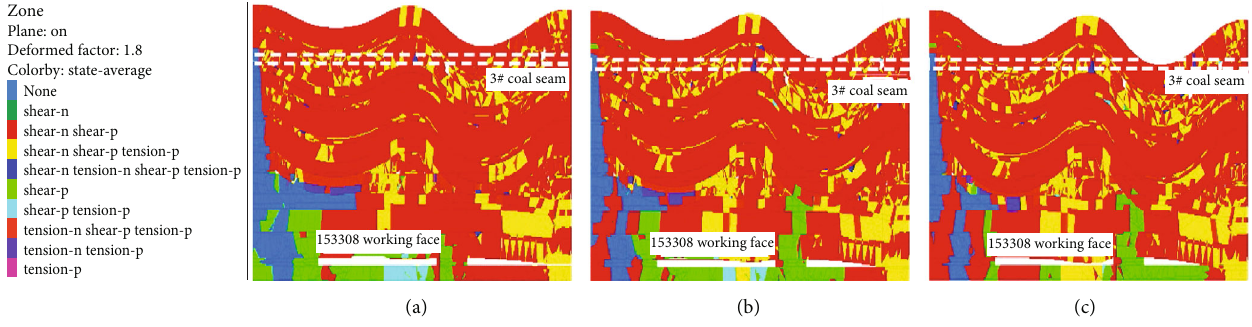
Figure 8: Cloud image of plastic zone in no. 3 coal seam during mining of 153308 working face. (a) Working face advancing 80m; (b) working face advancing 160m; (c) working face advancing